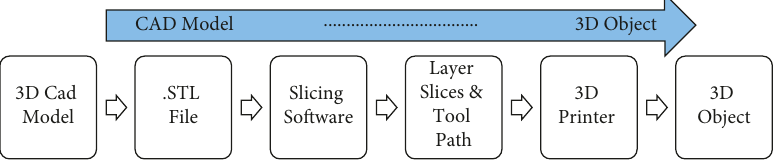
Figure 1: Basic steps of the FDM process.